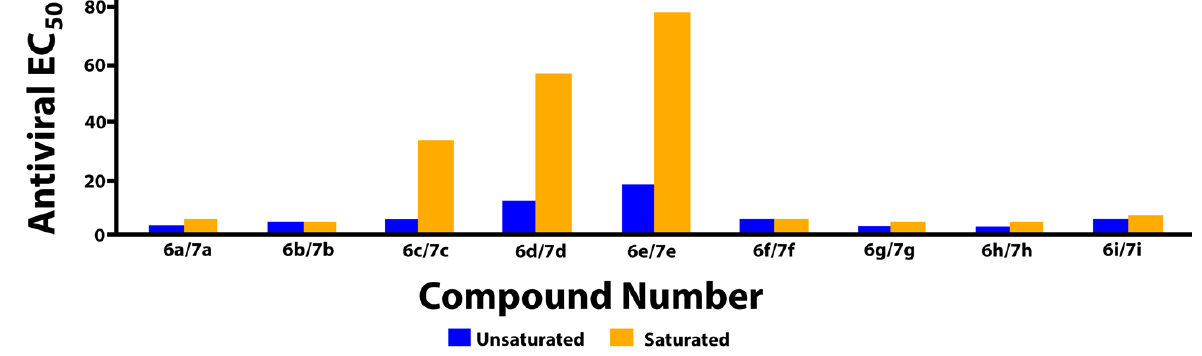
Figure 2. Comparison of antiviral potencies for saturated versus unsaturated analogs.